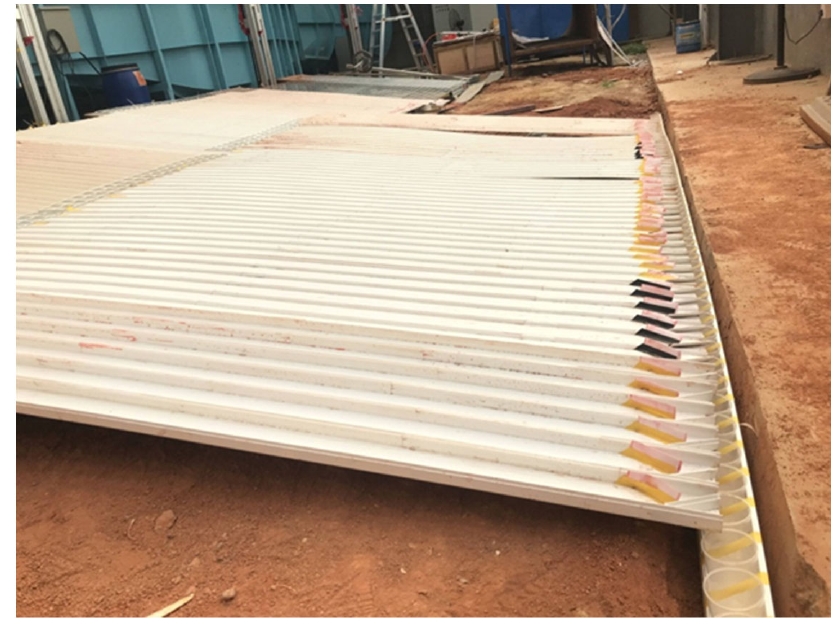
Figure 10. Collecting flumes and measuring cups.